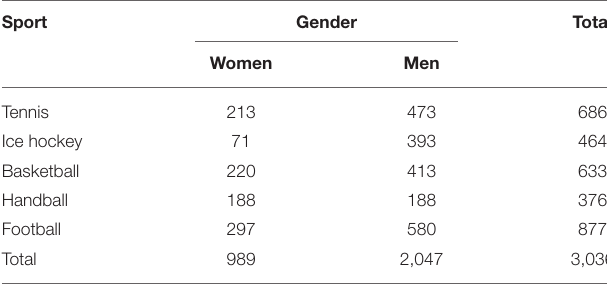
TABLE 1 | Number of respondents by sport and